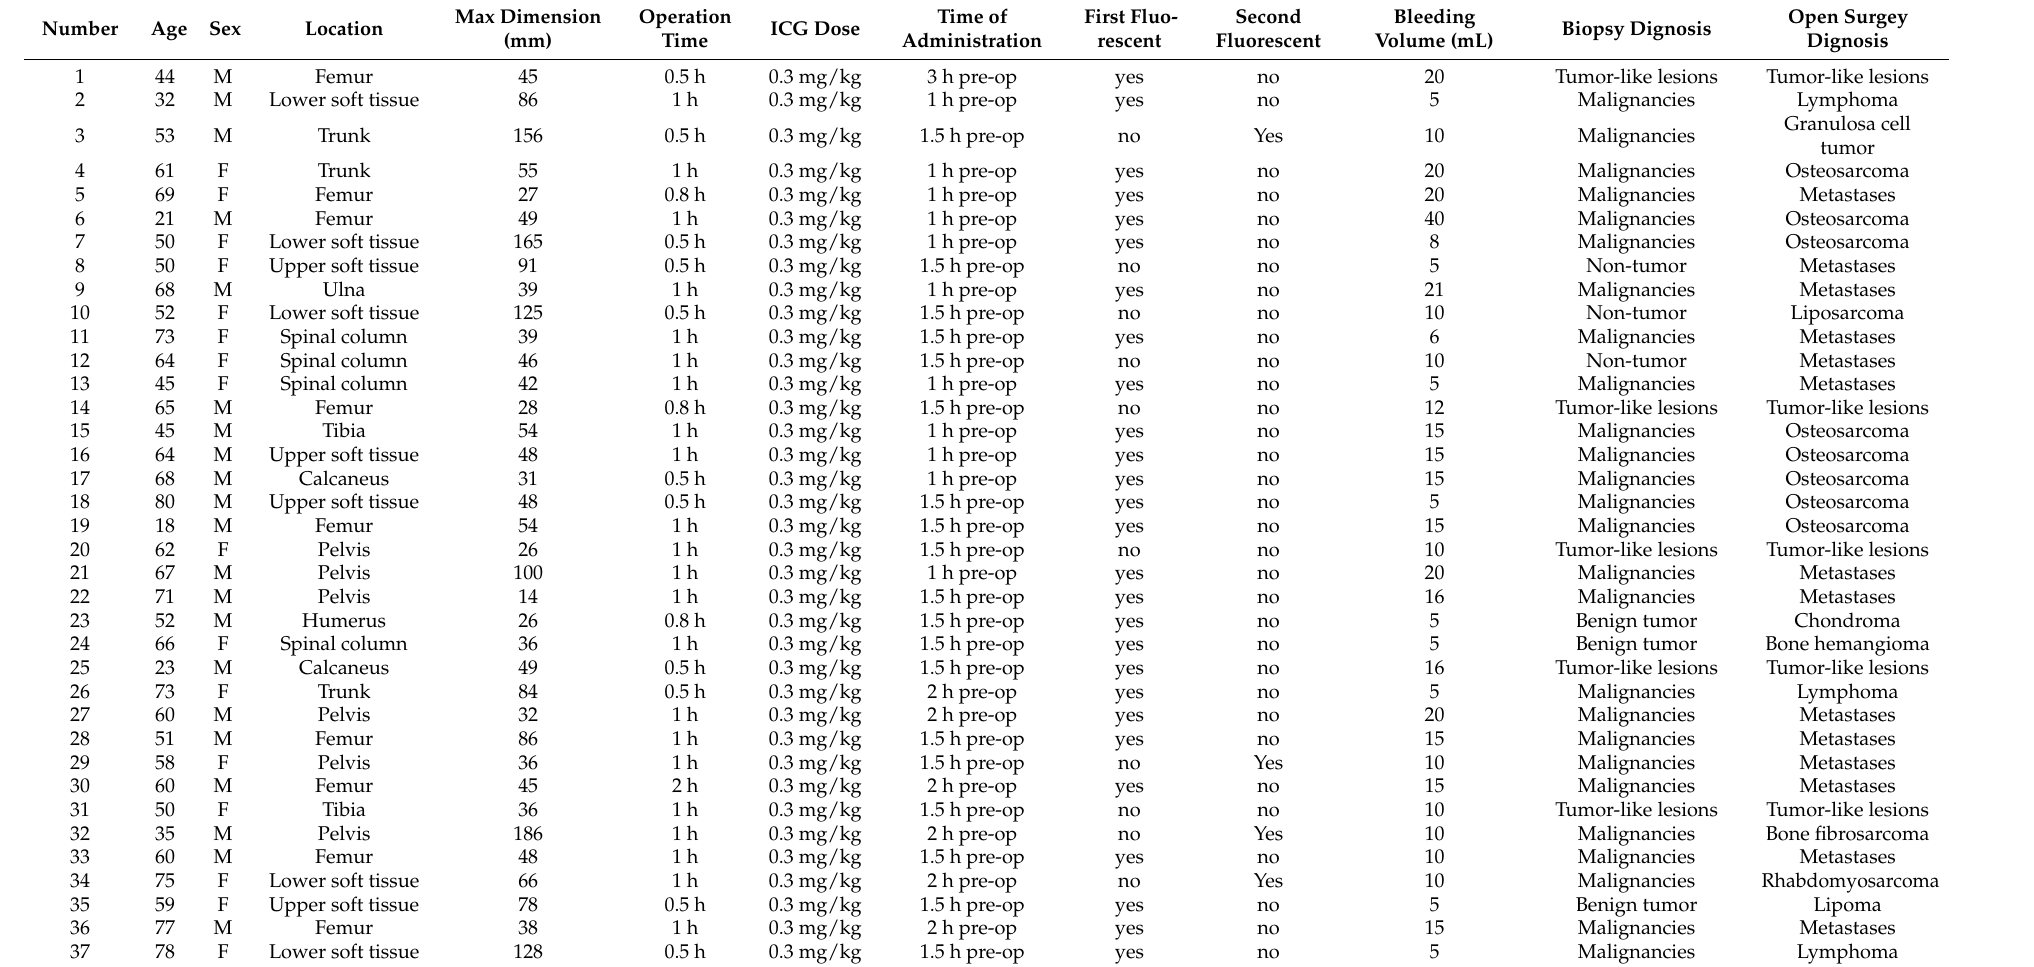
Table 4. Characteristics and effect of real-time fluorescence development in the test